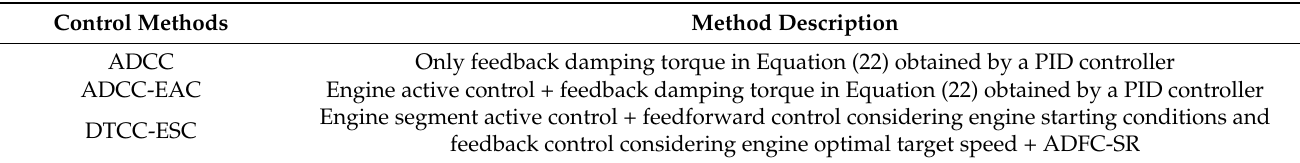
Table 3. Three Control Method Description.